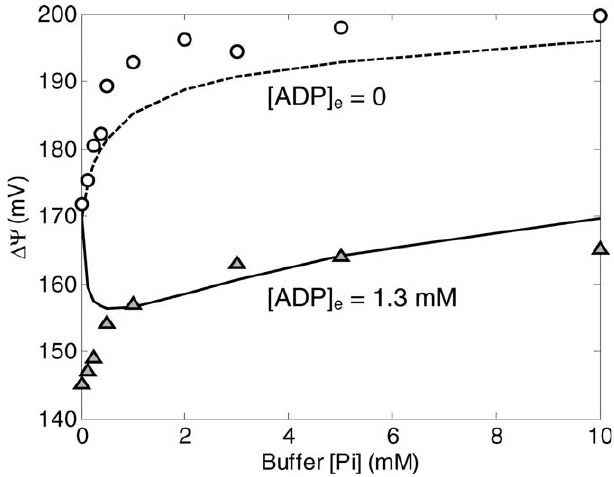
Figure 5. Comparison of Model Simulations to Experimental Data on Membrane Potential for Model with Phosphate Control The model with phosphate control compares much more favorably to the experimental measurements than the model without phosphate control (see Figure 3). Computed results in this figure correspond to steady-state simulations of the model described under ‘‘ Mitochondrial Model with Phosphate Control. ’’ Model simulations for [ADP] e ¼ 1.3 mM and [ADP] e ¼ 0 mM are plotted as solid lines and dashed lines, respectively; experimental data are the same as plotted in Figure 3. DOI: 10.1371/journal.pcbi.0010036.g005